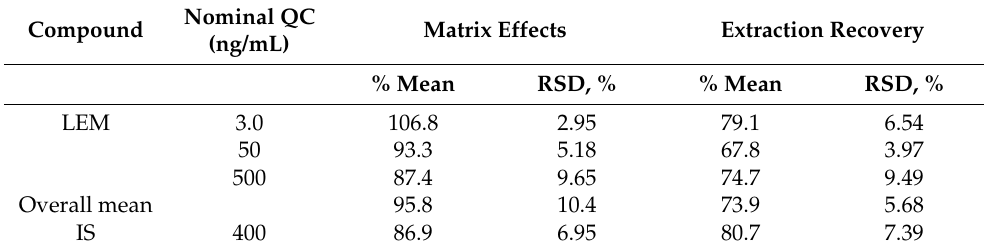
Table 4. Matrix effects and recovery percentage of LEM and IS in plasma ( n =